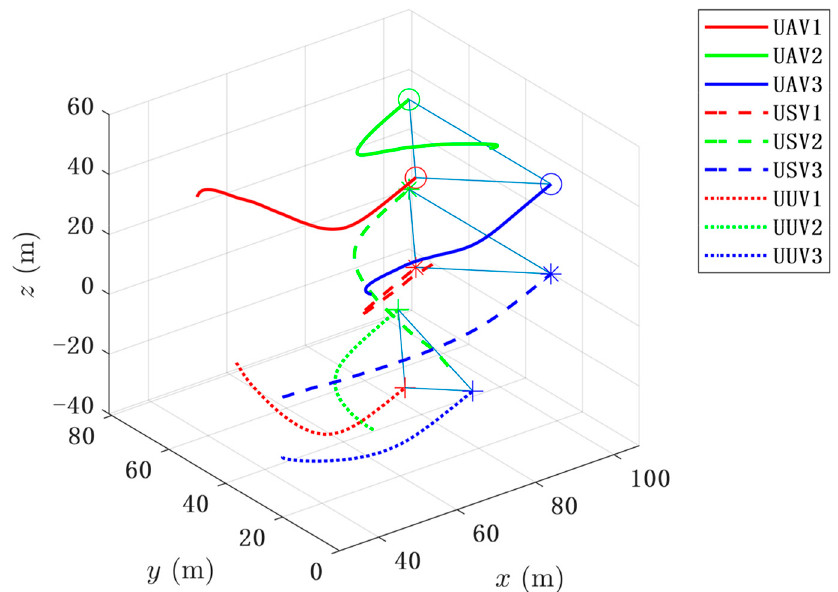
Figure 6. Formation state with dynamic formation control.